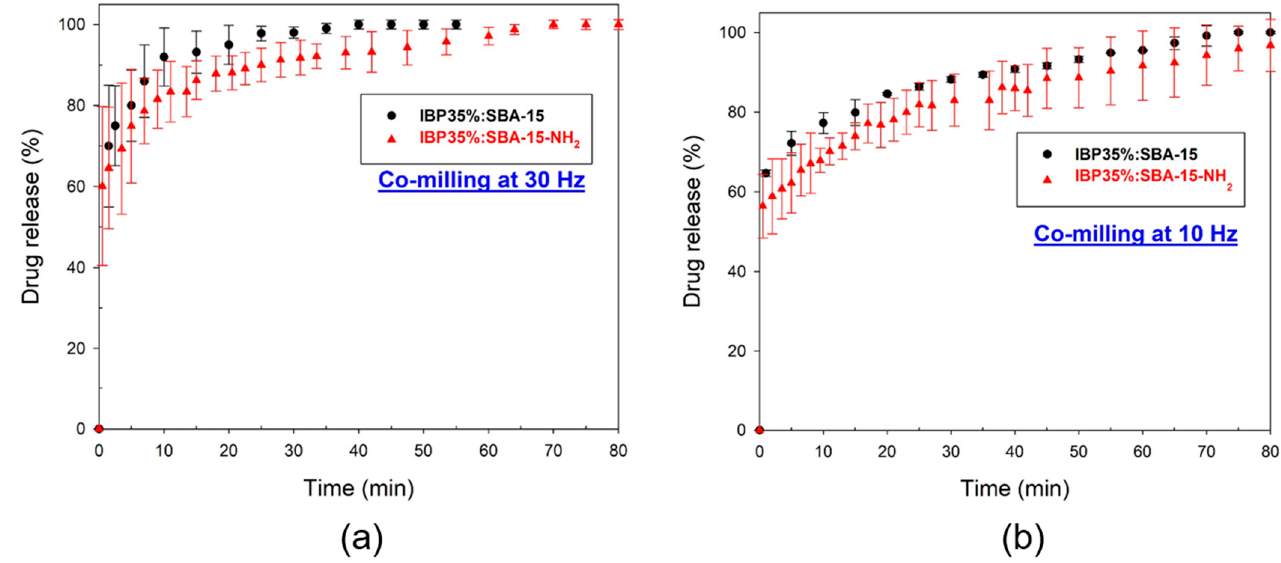
Figure A6. Release profiles of ibuprofen from SBA-15 and SBA-15-NH 2 : ( a ) co-milled at 30 Hz and ( b ) co-milled at 10 Hz.